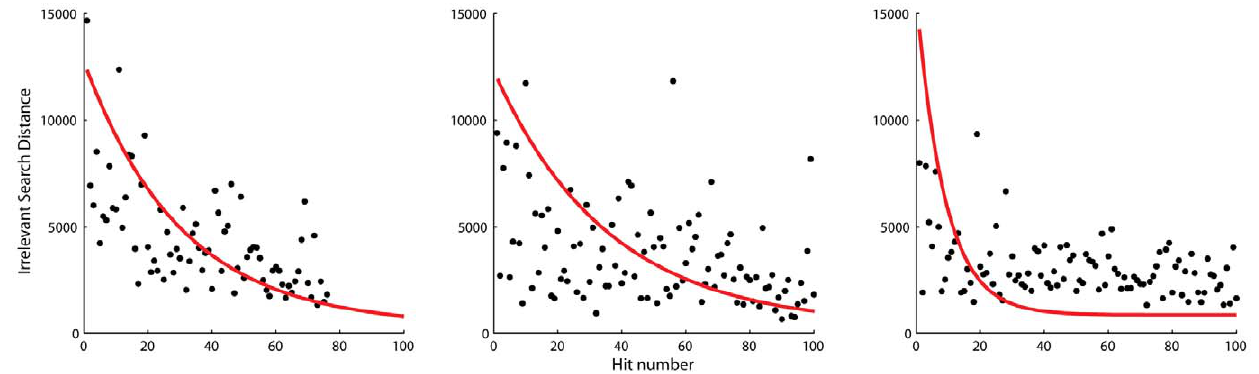
Figure 5. Rat performance follows the power law of learning. N=6.